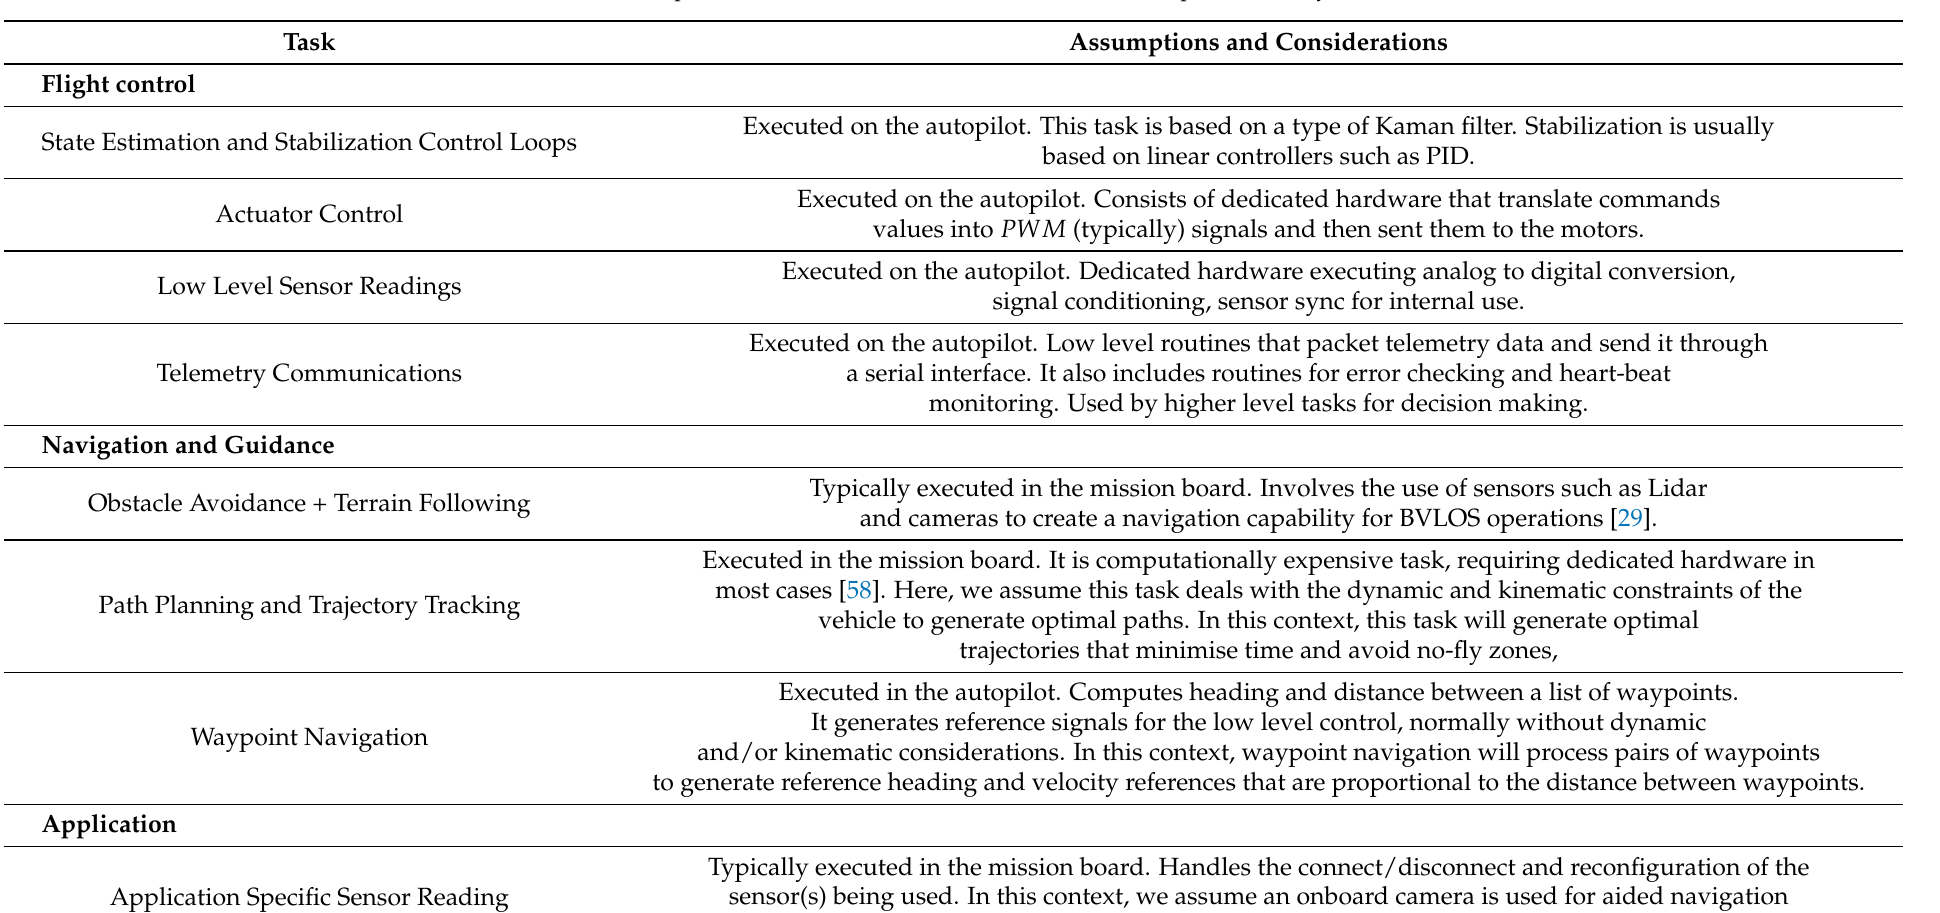
Table 4. Assumptions and considerations for each onboard task in parcel delivery